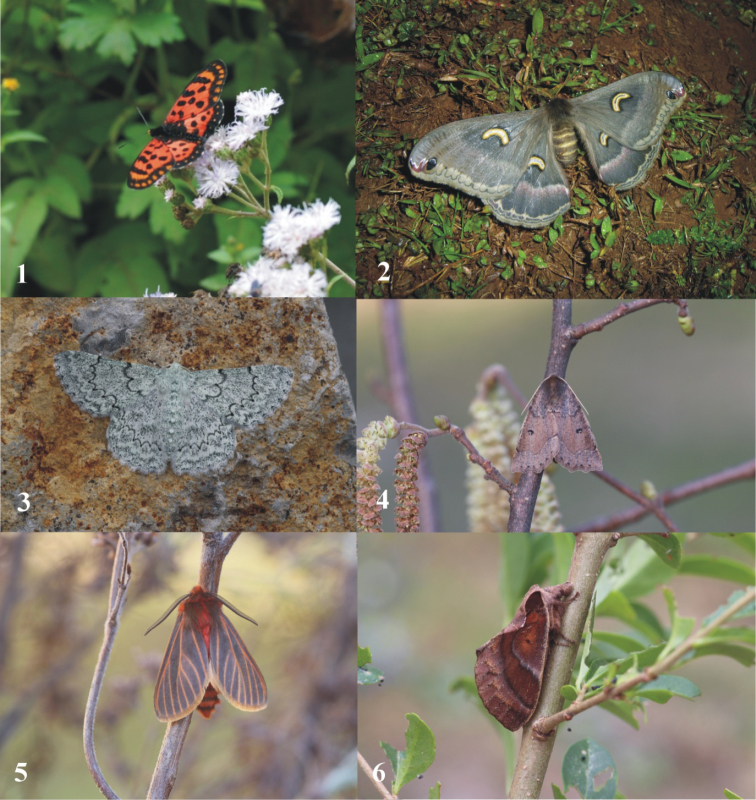
1Acraea
oscari Rothschild, 1902 2Epiphora
fournierae (Le Moult, 1945) 3Pingasa
pallidata (De Joannis, 1913) 4Odontopera
protecta Herbulot, 1983 5Metarctia
flavivena Hampson, 1901 6Stoermeriana
laportei (Rougeot, 1977). Photos credit: Alenuccio Palladino (1); Francesco Parisi (2); Dirk Stadie (3–6).